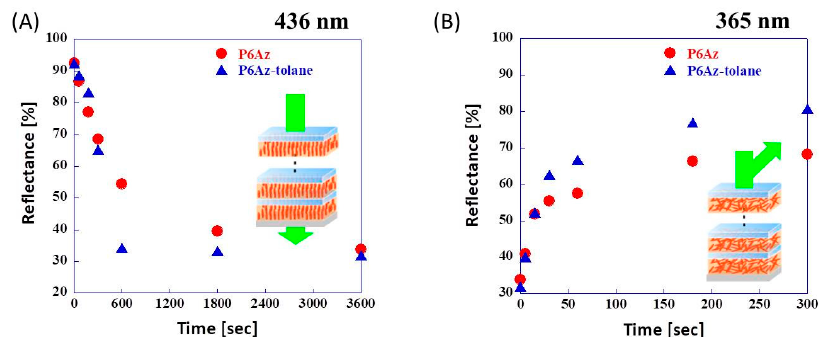
Figure 12. Reflectance change of the P6Az/PVA 20-multi-bilayered film and P6Az–tolane/PVA 20-multi-bilayered film under ( A ) visible light (436 nm) and ( B ) UV light (365 nm). Source: Kim et al. 2017 [51]. Copyright 2017. Reprinted with permission from Royal Society of Chemistry.